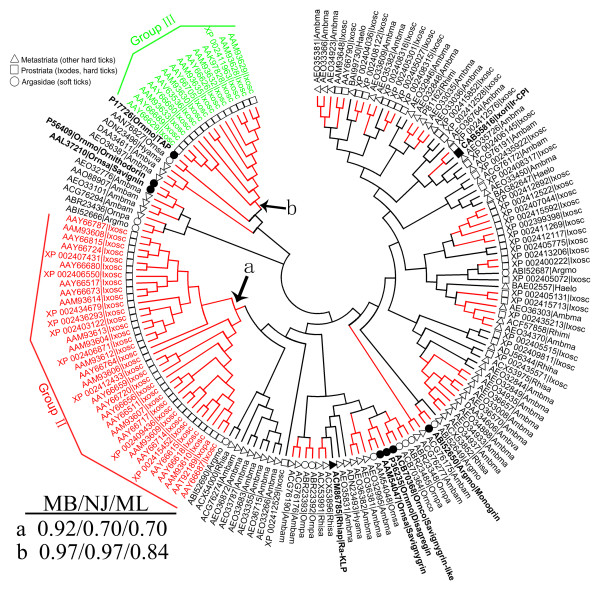
Neighbor-joining tree for all single-domain Kunitz/BPTI proteins in ticks. The circular phylogram (NJ tree) is based on alignment of all single-domain Kunitz/BPTI proteins in Ixodes scapularis and other ticks. The red branches have bootstrap support above 50%. Group II and group III, which are highlighted, are lineage-specific expansions of Kunitz/BPTI family in the genus Ixodes. The support values for these two groups (in MB, NJ, and ML tree) were shown in left bottom. The circle, square and triangle in the phylogram indicate the proteins from soft ticks, the genus Ixodes (hard ticks) and other hard ticks, respectively. The sequence name consists of 5 letters (3 from the genus and 2 from the species name) with the NCBI accession number. (Argmo, Argas monolakensis; Ornco, Ornithodoros coriaceus; Ornmo, Ornithodoros moubata; Ornpa, Ornithodoros parkeri; Ornsa, Ornithodoros savignyi; Rhiap, Rhipicephalus appendiculatus; Rhisa, Rhipicephalus sanguineus; Ixosc, Ixodes scapularis; Ixopa, Ixodes pacificus; Ixori, Ixodes ricinus; Rhimi, Rhipicephalus microplus; Hyama, Hyalomma marginatum rufipes; Ambam, Amblyomma americanum; Haelo, Haemaphysalis longicornis).